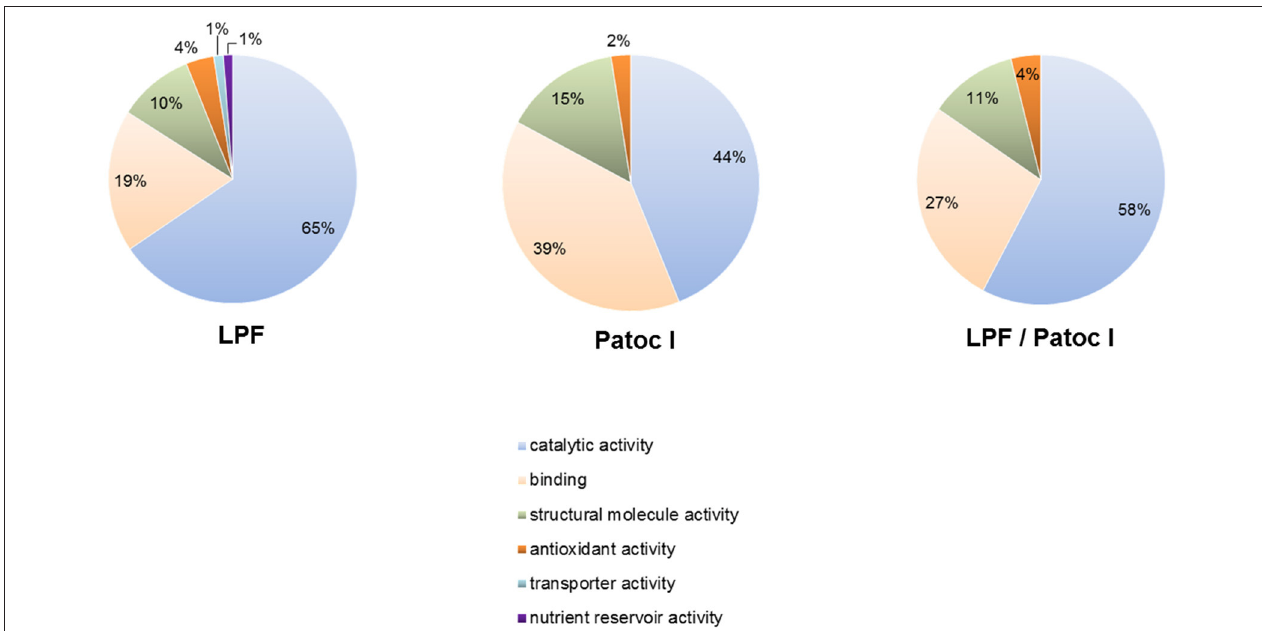
FIGURE 5 | Assignment of secreted proteins to Clusters of Orthologous Groups of proteins (COGs). The proteins identified in L. interrogans and L. biflexa exoproteomes were classified within the molecular function category. The predicted percentage of proteins in each subcategory is indicated. Pie charts of LPF unique proteins, Patoc I unique proteins and common proteins (LPF/Patoc I) are